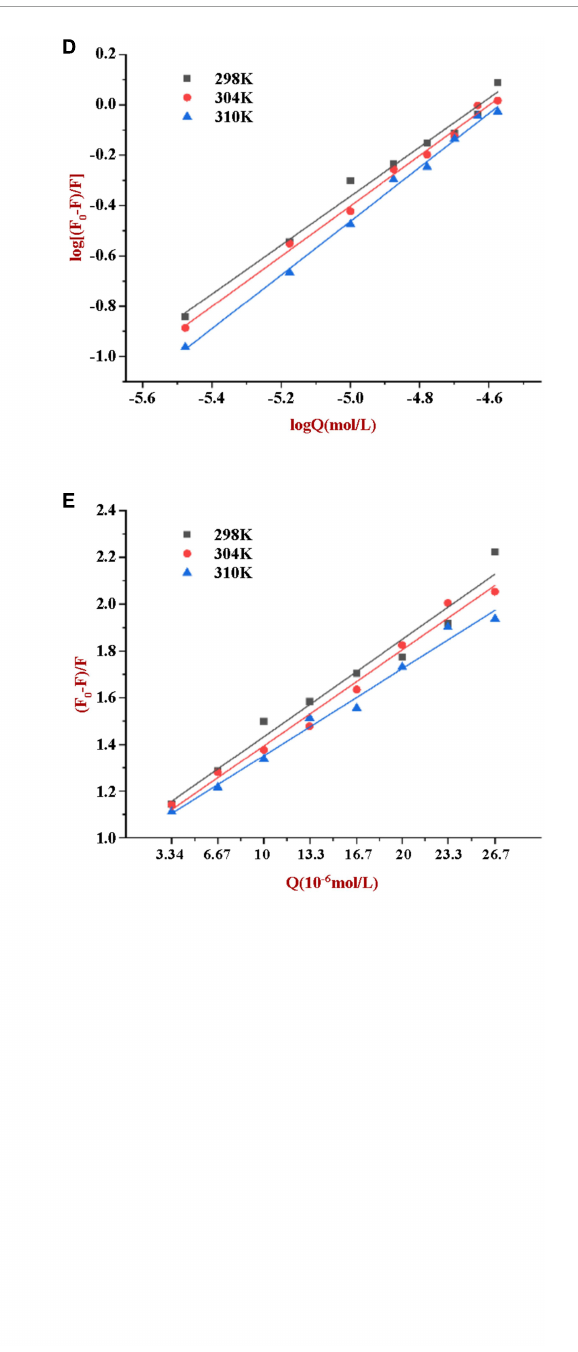
different temperatures to explore the interactions between HES and WP. As shown in Figure 1 , a strong fluorescence emission peak at approximately 345 nm was observed. The fluorescence intensity decreased gradually as the HES content was increased. Moreover, a slight red shift of about 2 nm occurred in the